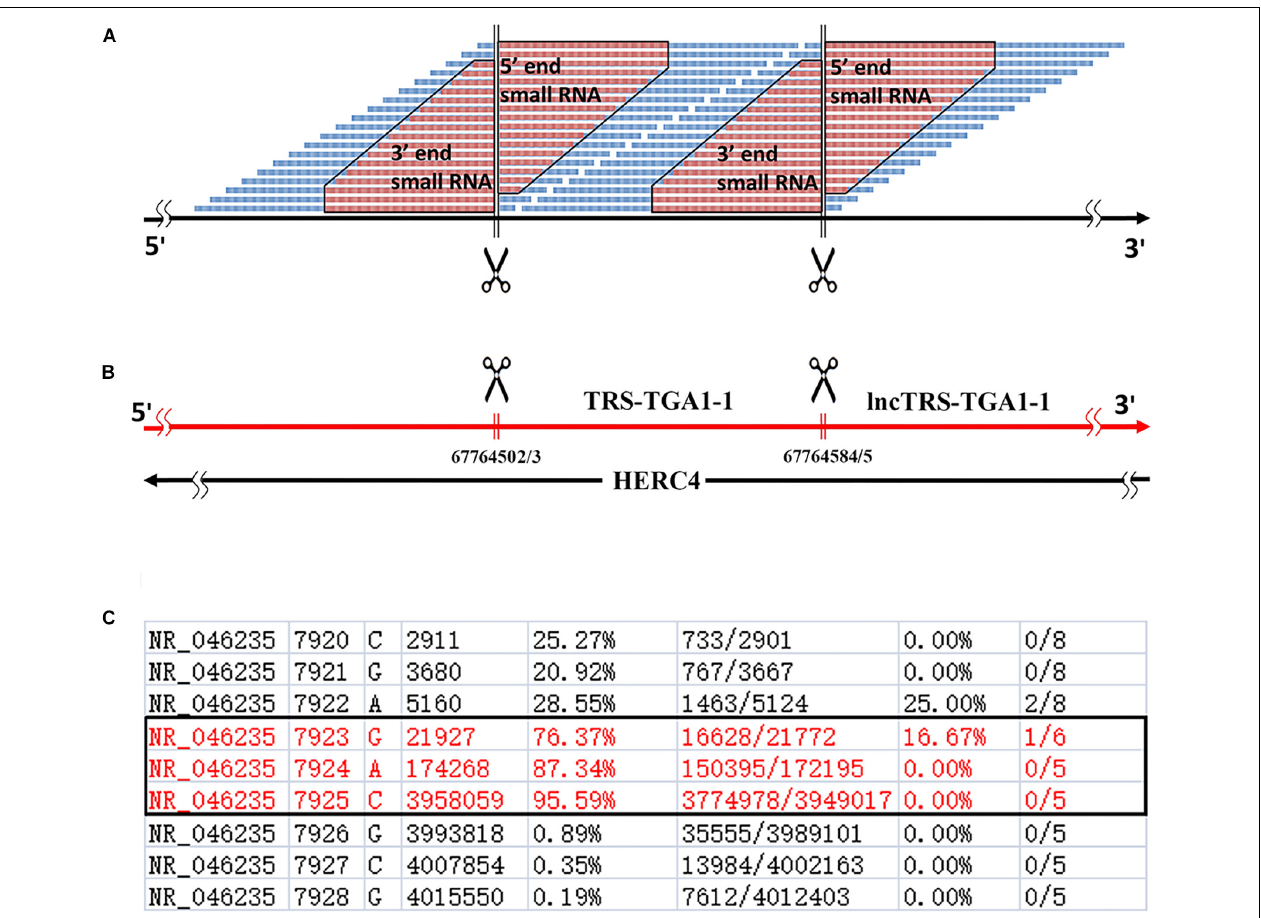
FIGURE 1 | Definition of 5 (cid:48) and 3 (cid:48) sRNAs. (A) 5 (cid:48) and 3 (cid:48) sRNAs (in red color) are defined as sRNA-seq reads with lengths of 15 ∼ 50 bp, which are precisely aligned to the 5 (cid:48) and 3 (cid:48) ends of mature RNAs, respectively. The lengths of them vary progressively with 1-bp differences. This figure shows 5 (cid:48) and 3 (cid:48) sRNAs from a typical tRNA (in blue color). As for longer RNAs (e.g., snRNAs or rRNAs), there could be abundant sRNAs in the body. (B) 5-end format is defined to easily identify 5 (cid:48) ends of mature RNAs using sRNA-seq data. (C) Human rRNA genes (RefSeq: NR_046235.1) were annotated using alignment results in the 5-end format. Among positions 7923, 7924, and 7925 with ratio1s (the 5th column) above 70%, the position 7925 with the highest ratio1 was determined as the 5 (cid:48) end of 28S